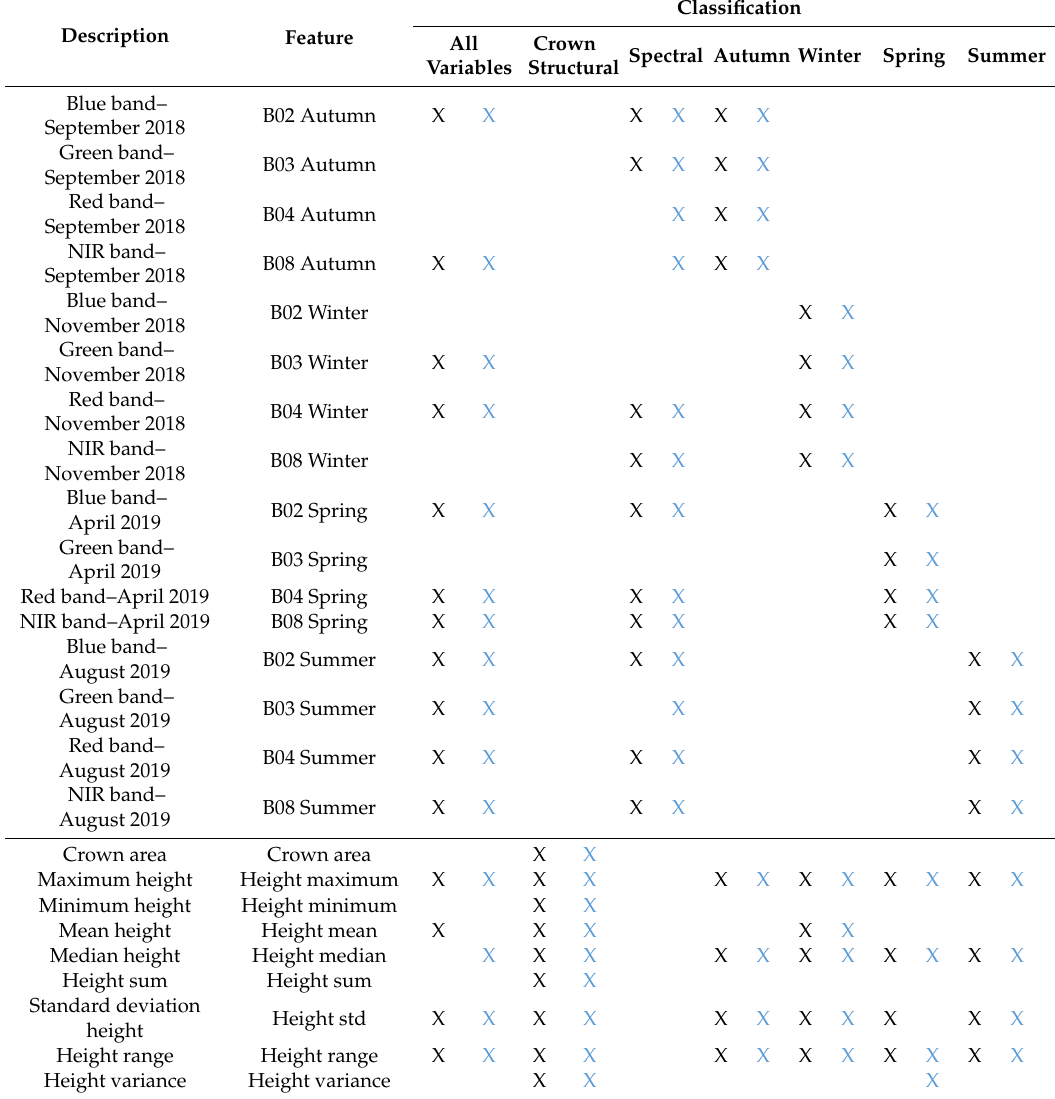
Table A4. The spectral and crown structural variables used in the Random Forest model. The black X’s indicate the selected variables at species level; the blue X’s indicate the ones selected at phylum